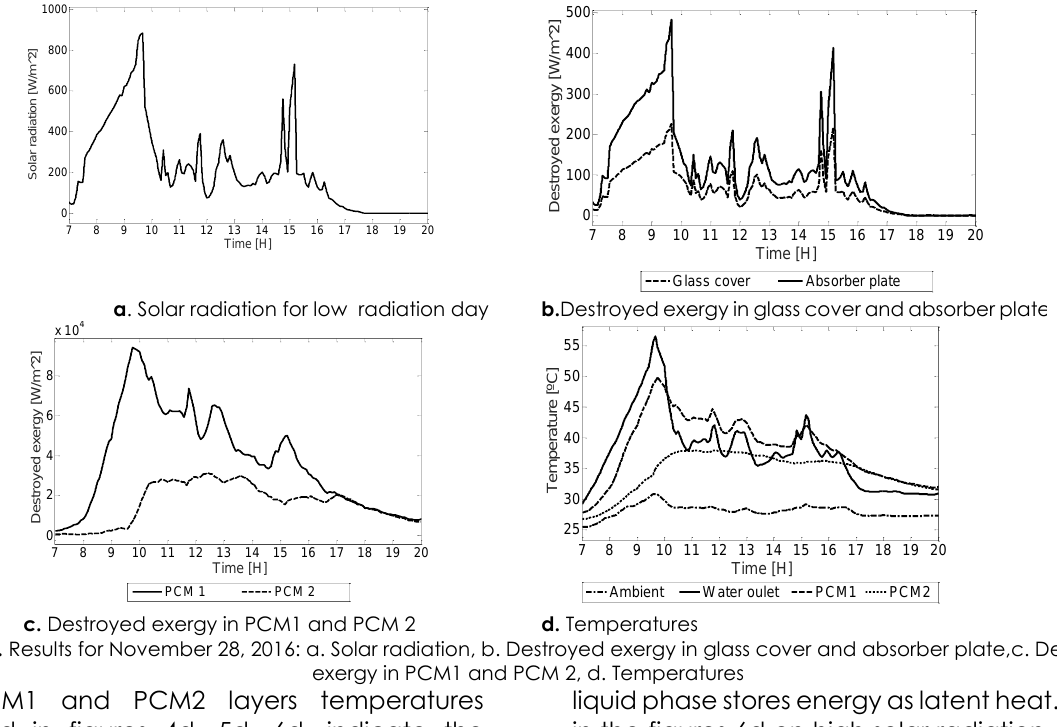
d. Temperatures Figure 4. Results for November 28, 2016: a. Solar radiation, b. Destroyed exergy in glass cover and absorber plate,c.